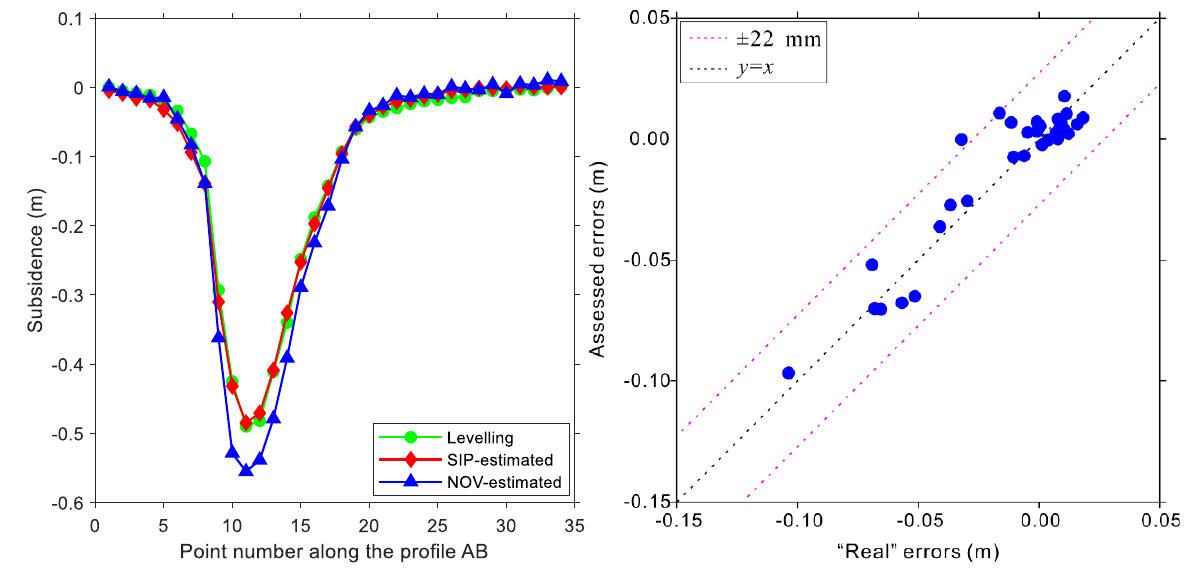
Figure 2. Left : Comparison between the SIP- and NOV-estimated subsidence with precise leveling observations of subsidence along the profile AB (34 points, marked by black crosses in Figure 1d). Right : Scatter plot between the “real” ( x -axis) and the assessed errors ( y -axis) of the NOV-estimated mining subsidence at 34 field points. The black dash line implies the perfect scenario in which both errors are equal. The magenta dashed lines denote two times the STD of the assessed errors with respect to the “real” ones.